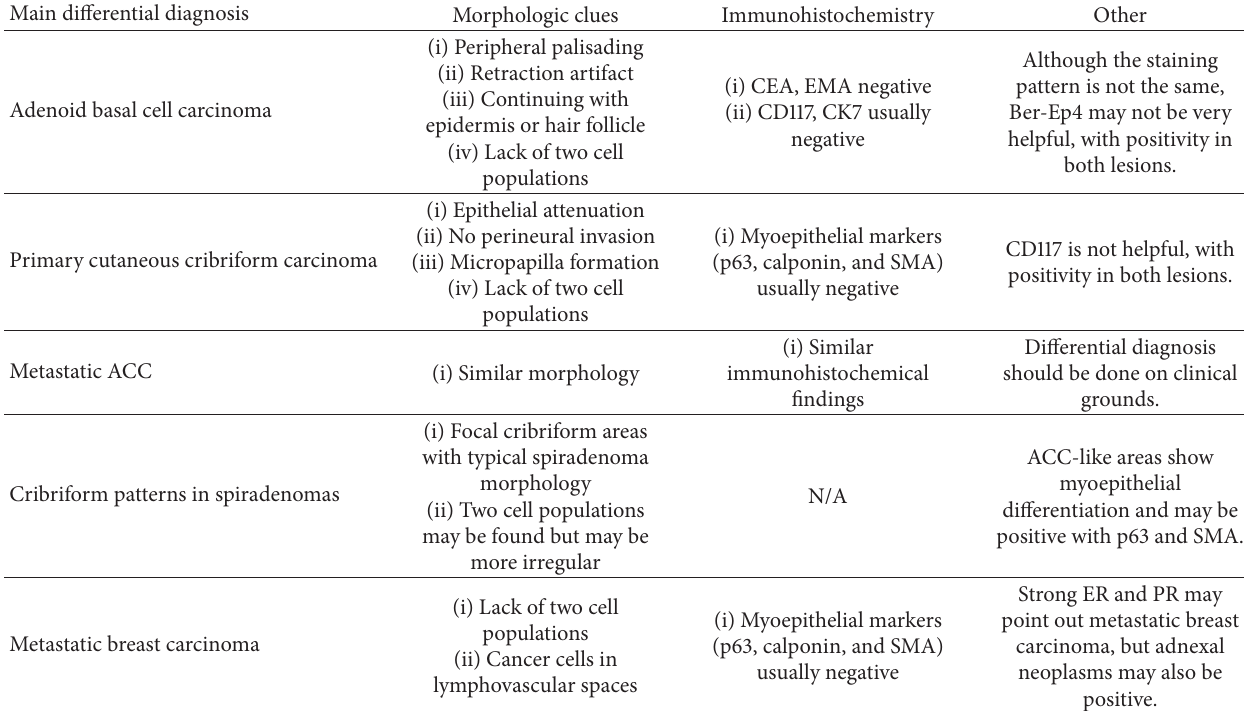
Table 2: Differential diagnosis of primary cutaneous adenoid cystic carcinoma.